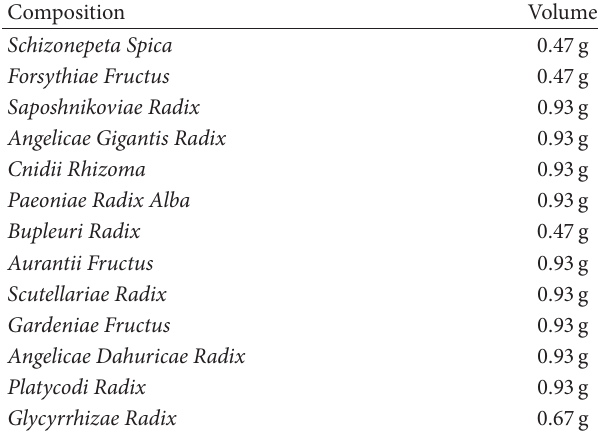
Table 1: The composition of herbal medicines in HYT.